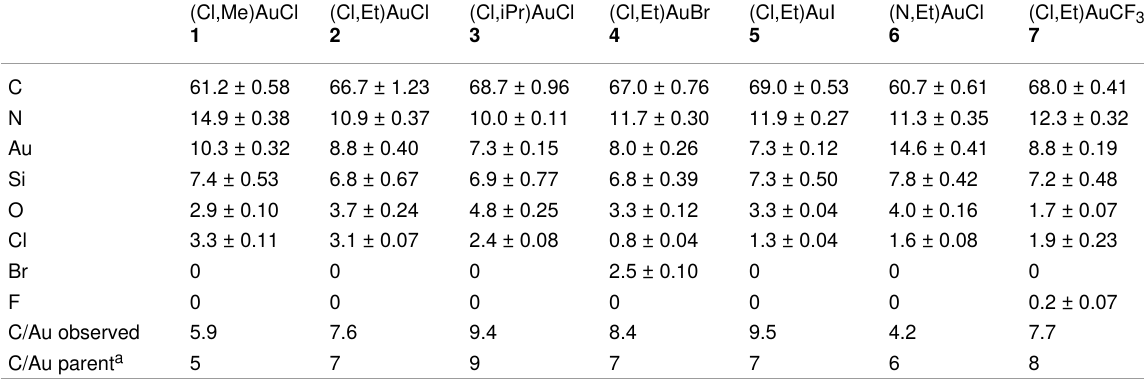
Table 2: Elemental composition of deposits obtained by EDX with all values given in atom %. In addition, the ratio between carbon content and gold content in the deposits and the corresponding parent molecules are given.